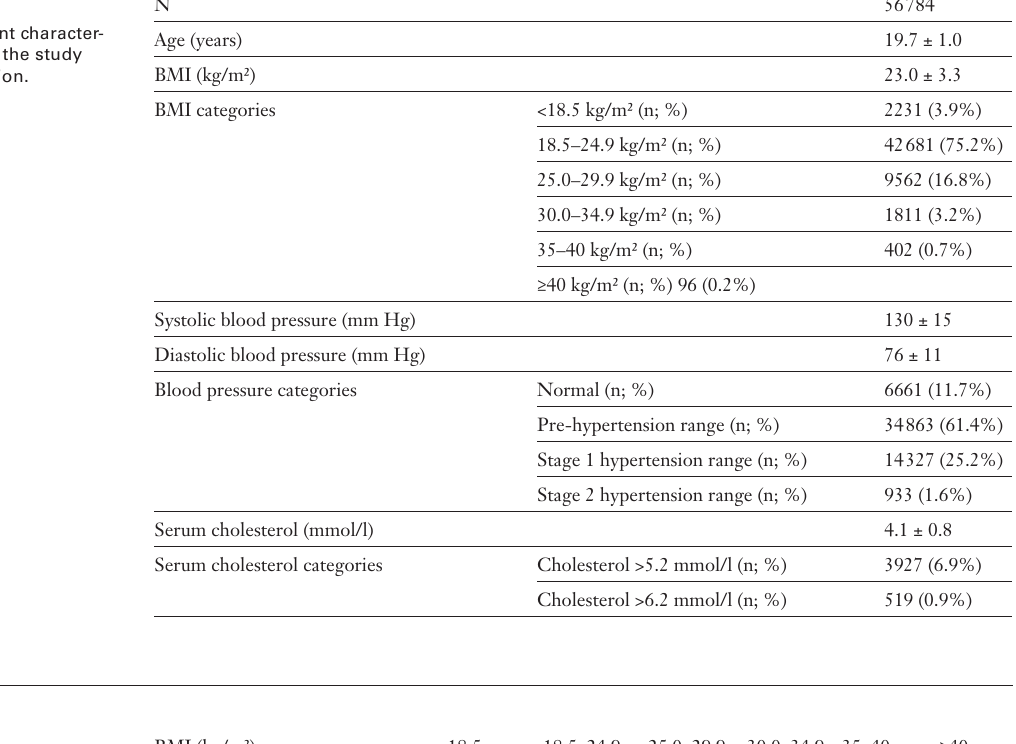
Blood pressure and serum cholesterol in BMI